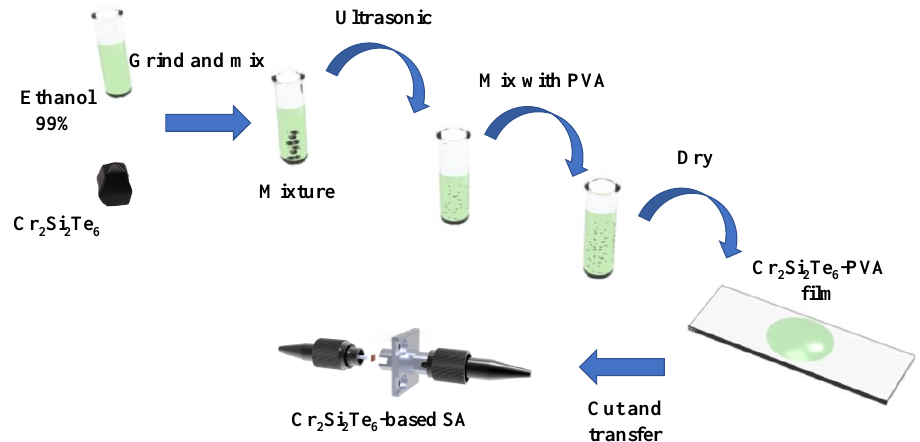
Figure 1. Preparation process of the Cr 2 Si 2 Te 6 -based SA.